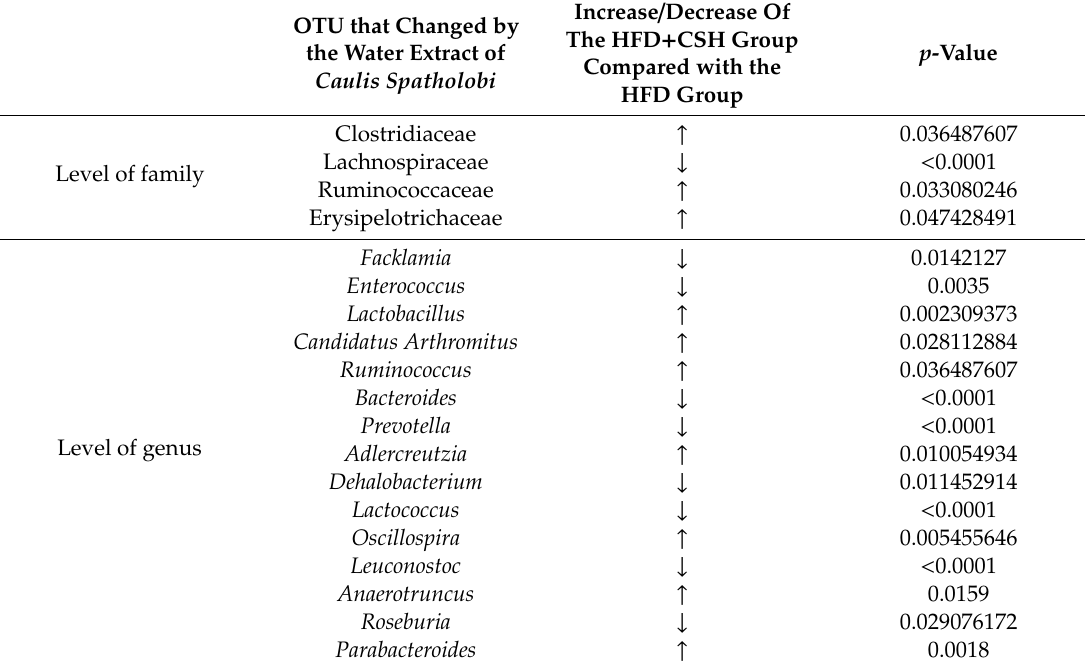
Table 1. OTU group trends after WECS treatment of HFD-fed mice. OTU that Changed